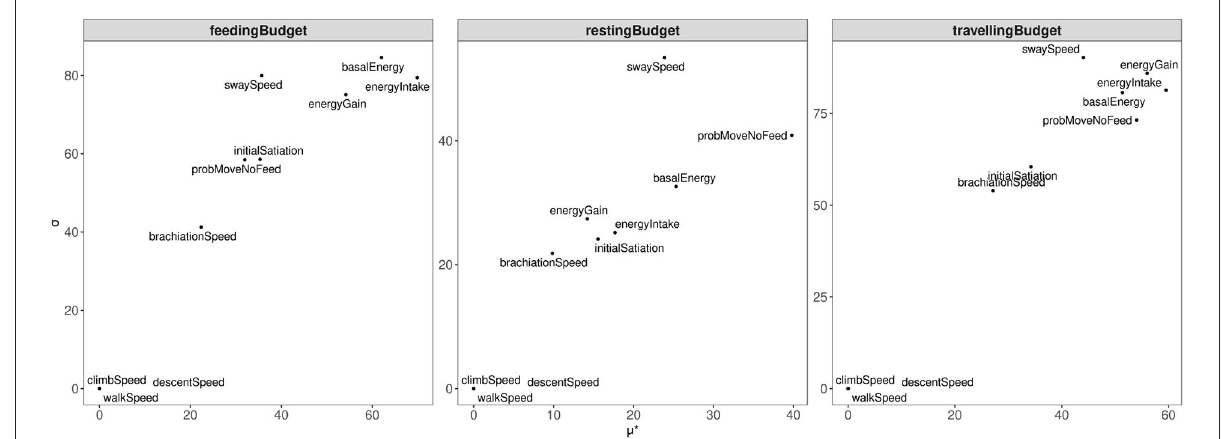
FIGURE5 Morris screening results. µ ∗ on the x-axis depicts the overall sensitivity of the parameter. σ on y-axis depicts the overall tendency of the parameter to interact with the